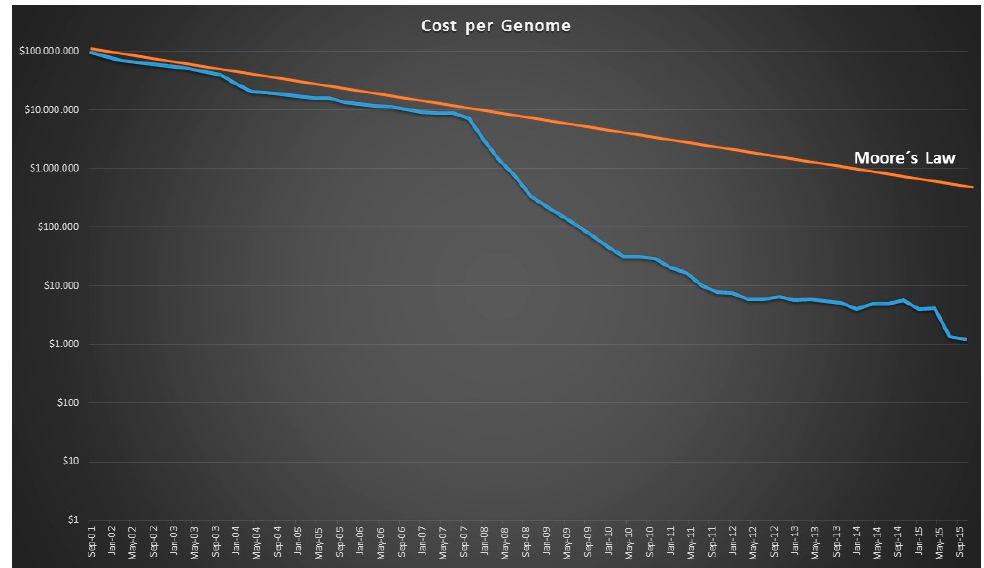
Figure 4. The evolution of the cost of sequencing a complete human genome from 2001 to 2015. The theoretical reduction predicted by Moore’s Law is also represented with a red line.